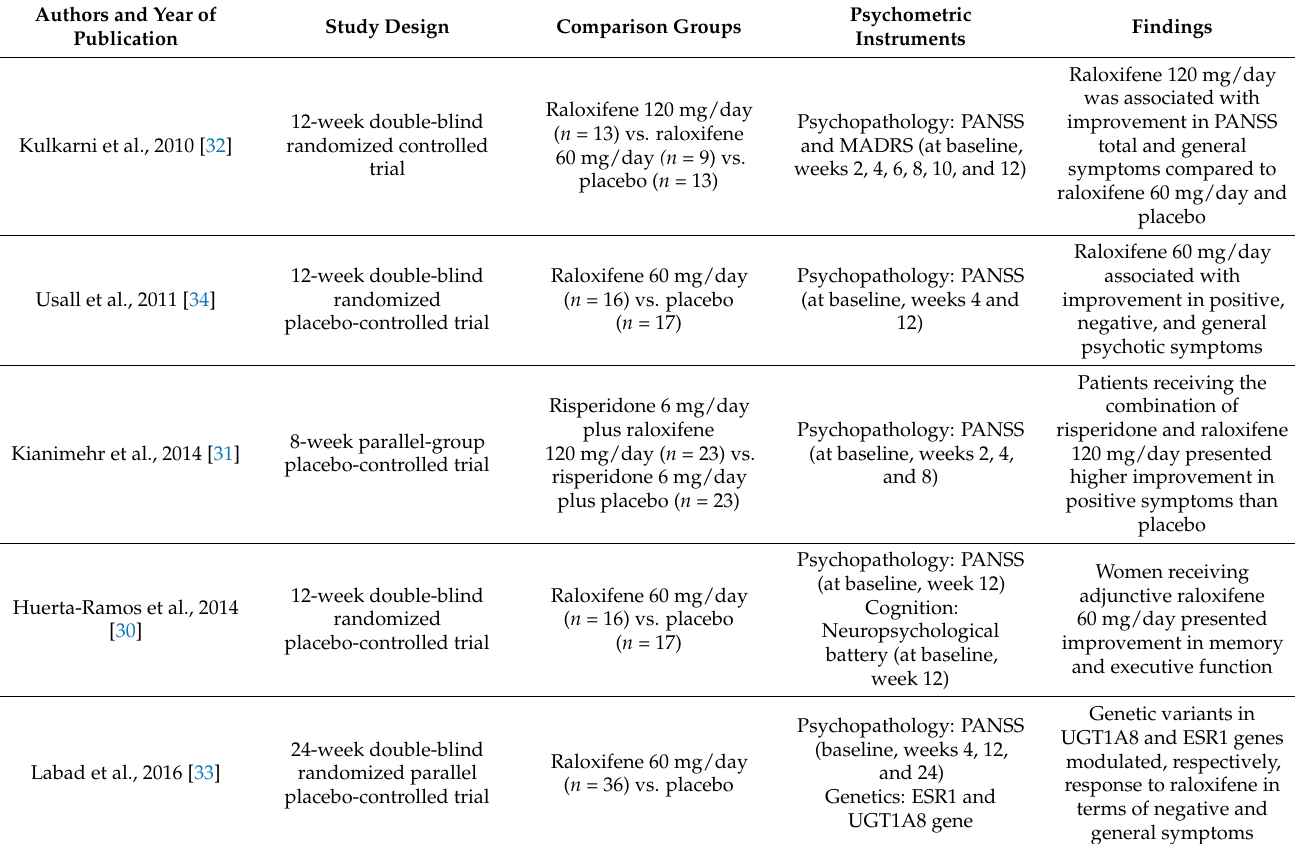
Table 1. Most relevant studies investigating the efficacy of raloxifene in the treatment of postmenopausal schizophrenia women ( n =